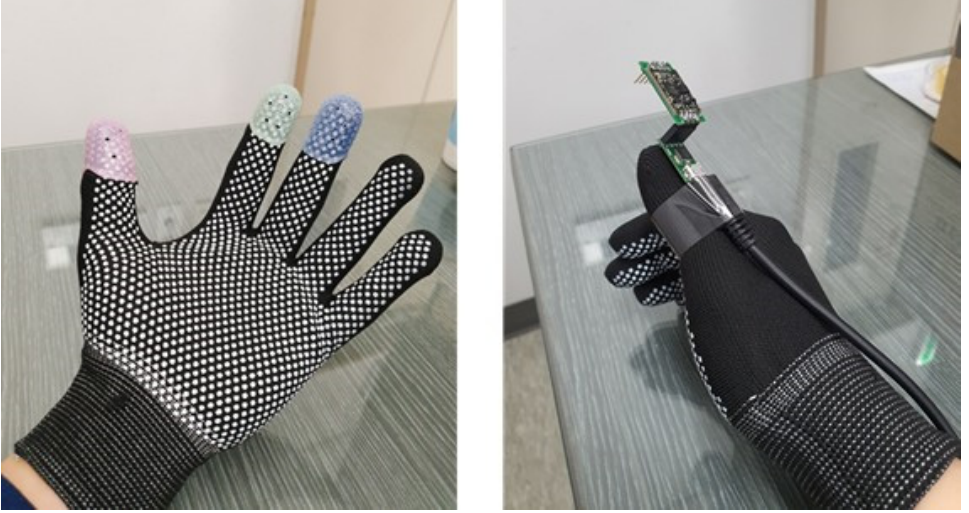
Figure 9. Wearable system for gesture recognition.